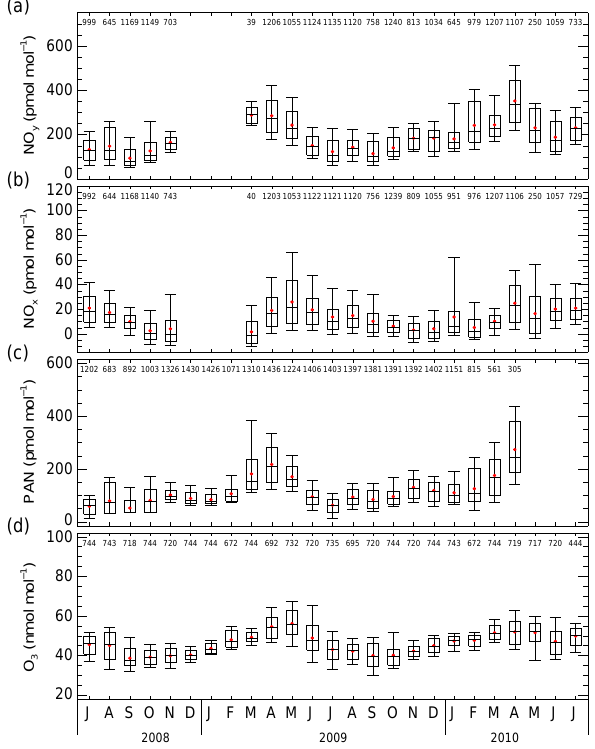
Figure 1. Monthly averages of (a) NO x , (b) NO y , (c) PAN, and (d) O 3 at Summit from July 2008 to July 2010. The median and mean of the data are represented by a horizontal line and filled black circle, respectively; the box indicates the middle 67% of the data; and the vertical whiskers indicate the 5th and 95th percentile of all the data. The numbers at the top of each plot represent the number of 30min averages included in the